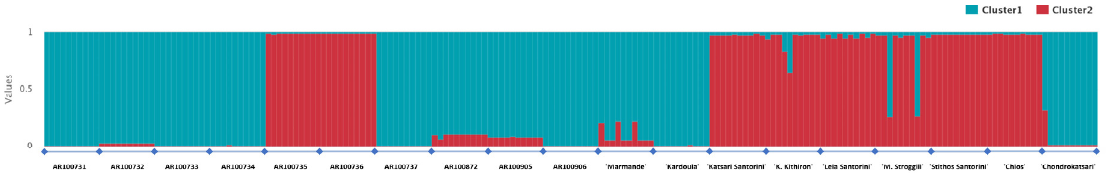
Figure 5. Structure analysis for Cypriot tomato germplasm depicting probability for genetic cluster assignment at K =